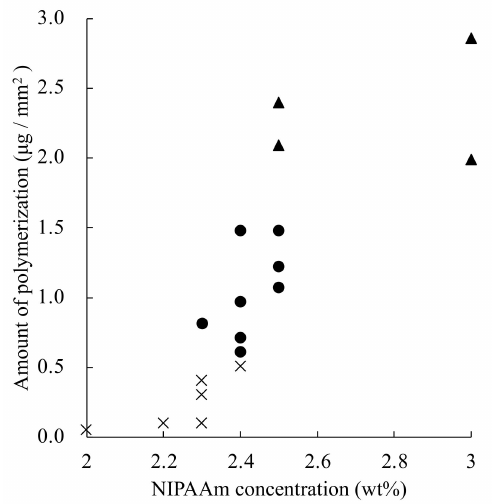
Figure 7. Relationship between polymerization of PNIPAAM and valve performance. × : the valve did not close, even at 25 ◦ C, • : the valve showed good valving performance, and (cid:78) : poor permeability was observed after valve opening.